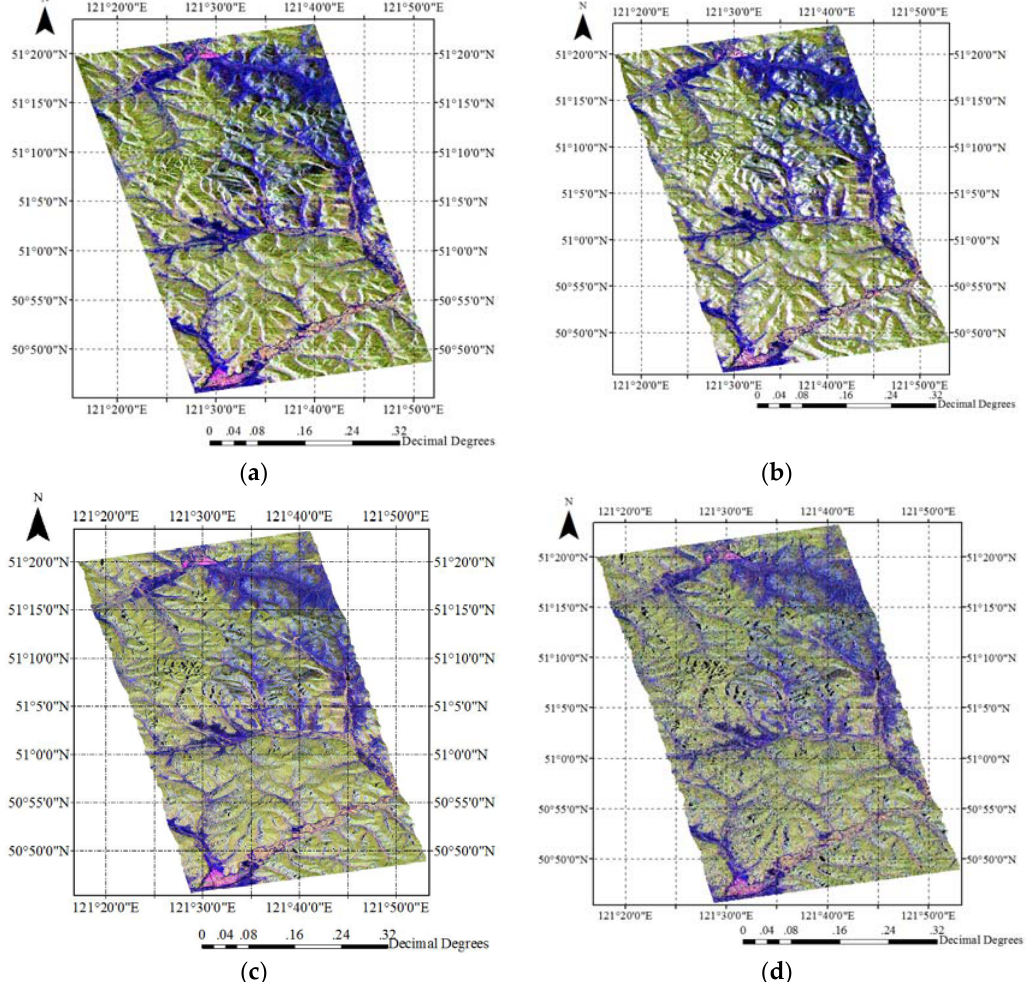
Figure 6. Terrain correction results on the ALOS PALSAR data sets for Genhe: ( a ) experiment data; ( b ) RD based geometric correction; ( c ) radiometric normalization correction; and ( d ) backscatter optimization radiometric correction.